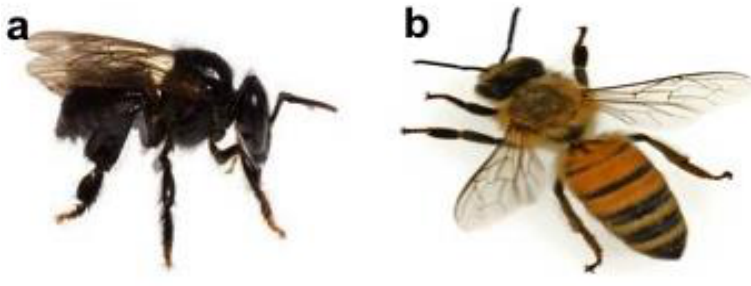
Figure 1. Di ff erent types of bees: ( a ) Heterotrigona itama bee, ( b ) Apis mellifera Figure 1. Different types of bees: ( a ) Heterotrigona itama bee, ( b ) Apis mellifera bee.